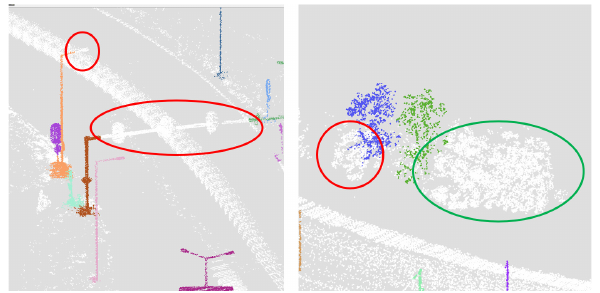
Figure 13. Points not segmented due to limiting growing constraints which is in some occasions not correct (red circles), and in some correct (green